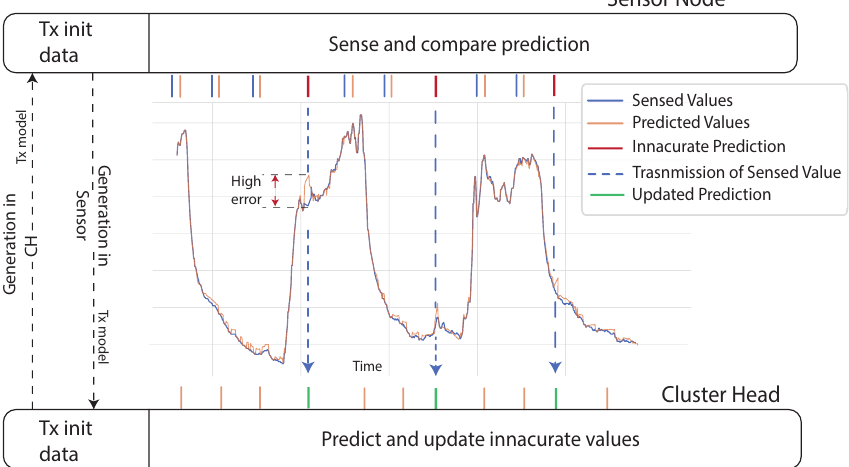
Figure 11. Dual prediction scheme operating on a Wireless Sensor